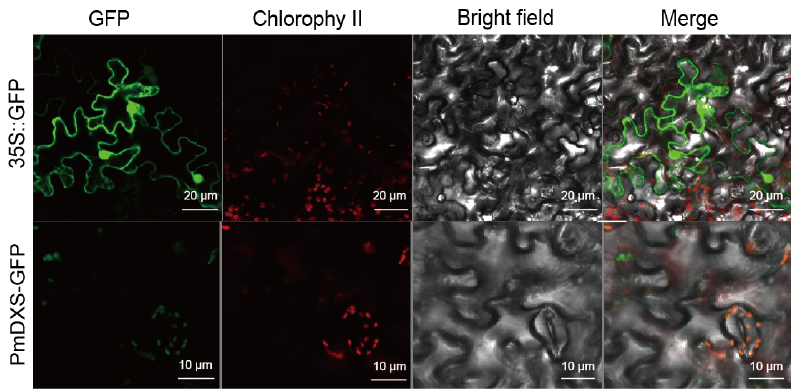
Figure 6. Subcellular localization of PmDXS in epidermal leaf cells of transiently infected N. ben- thamiana . Green is green fluorescent protein, red is chloroplast